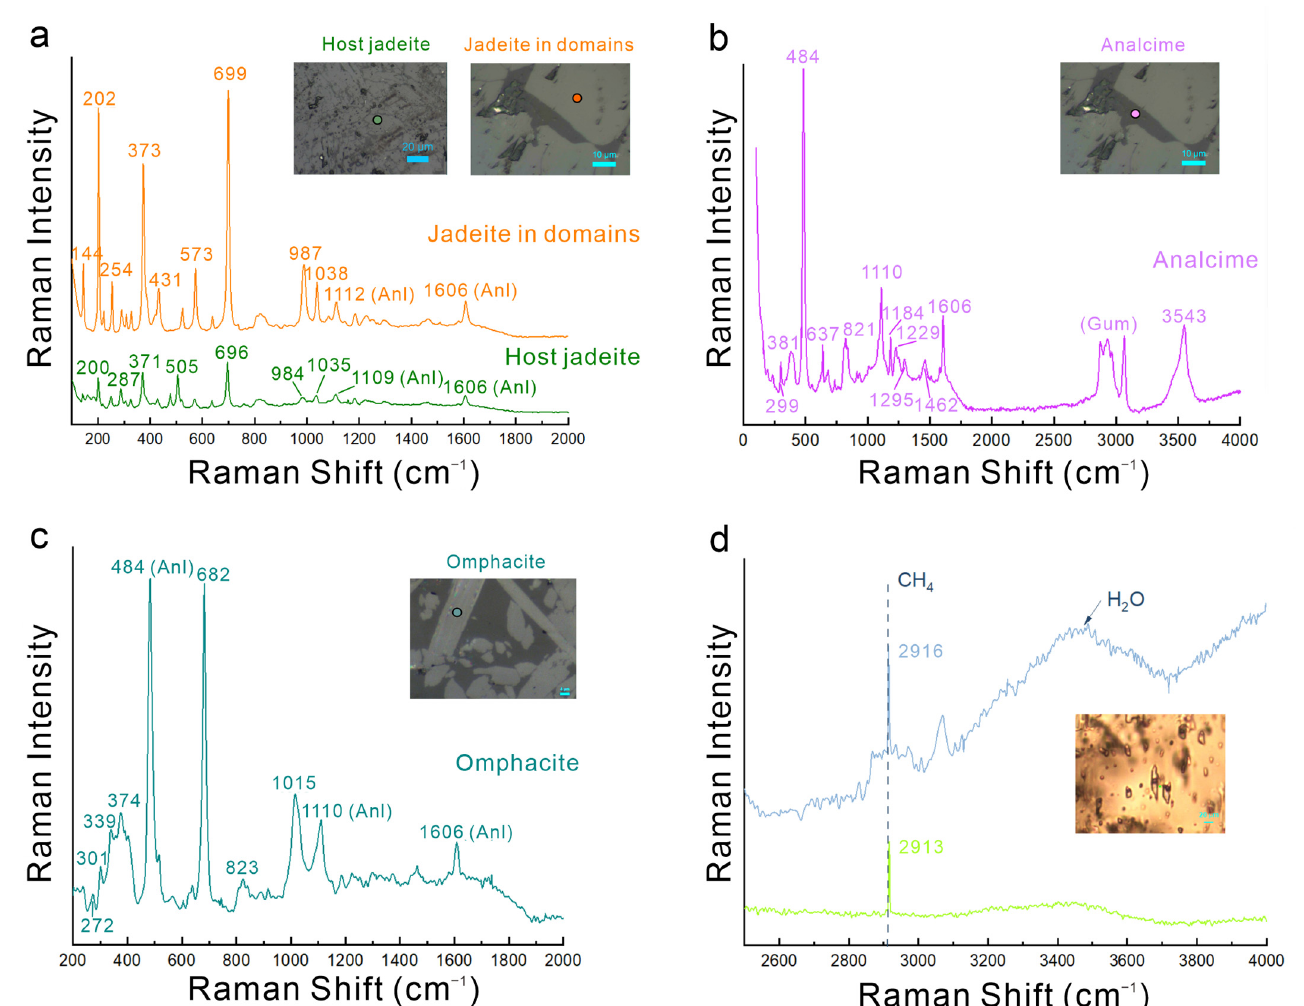
Figure 10. ( a ) Raman spectra of host jadeite and jadeite in domains. ( b , c ) Raman spectra reveal that the component of the filling grains in Type II is jadeite ( a ), analcime, and omphacite. ( d ) The fluid inclusions show distinct methane peak at ~2916 cm − 1 and peaks of H 2 O (Gum—Canadian gum on the thin section and Anl—analcime).